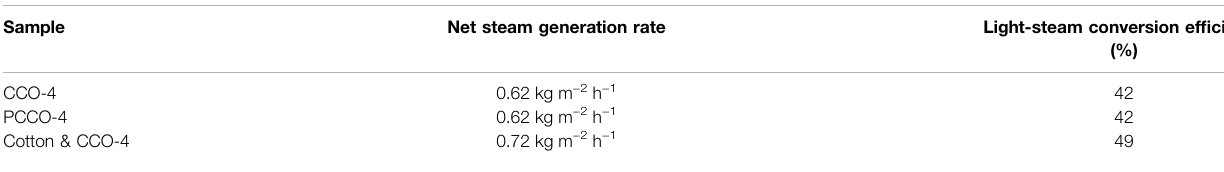
TABLE 2 | Solar-to-steam conversion ef fi ciency of cotton biochar. Sample